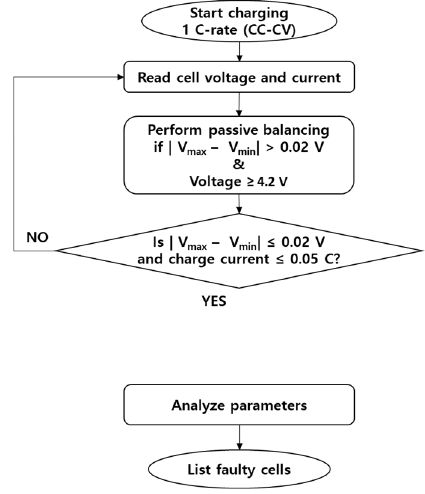
Figure 2. Flowchart of the algorithm. Table 3. Battery module specification.